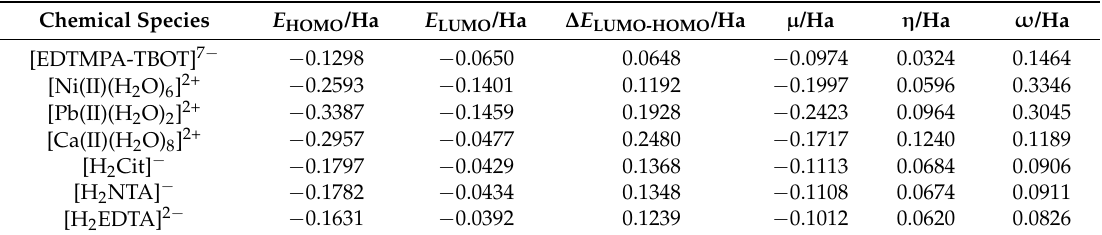
Table 1. Calculated E HOMO , E LUMO , ∆ E LUMO-HOMO , µ , η and ω in Hatree for the [EDTMPA-TBOT] 7 − ligand, Ni(II), the coexistent cations and complexing reagents.